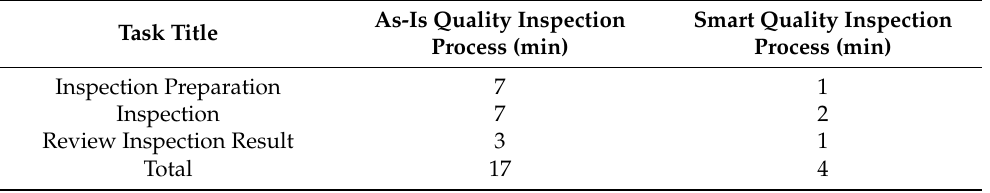
Table 8. Comparison of inspection time between as-is process versus smart quality inspection